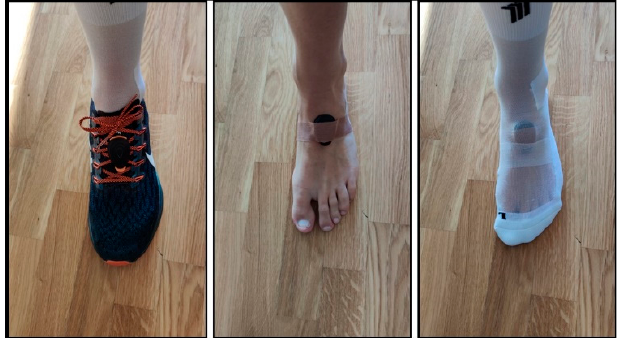
Figure 1. Representation for the placement of the Stryd™ power meter clipped on the laces of the runner’s shoe (left picture) and placed and secured with tape on the runner’s instep during barefoot running (central and right picture).